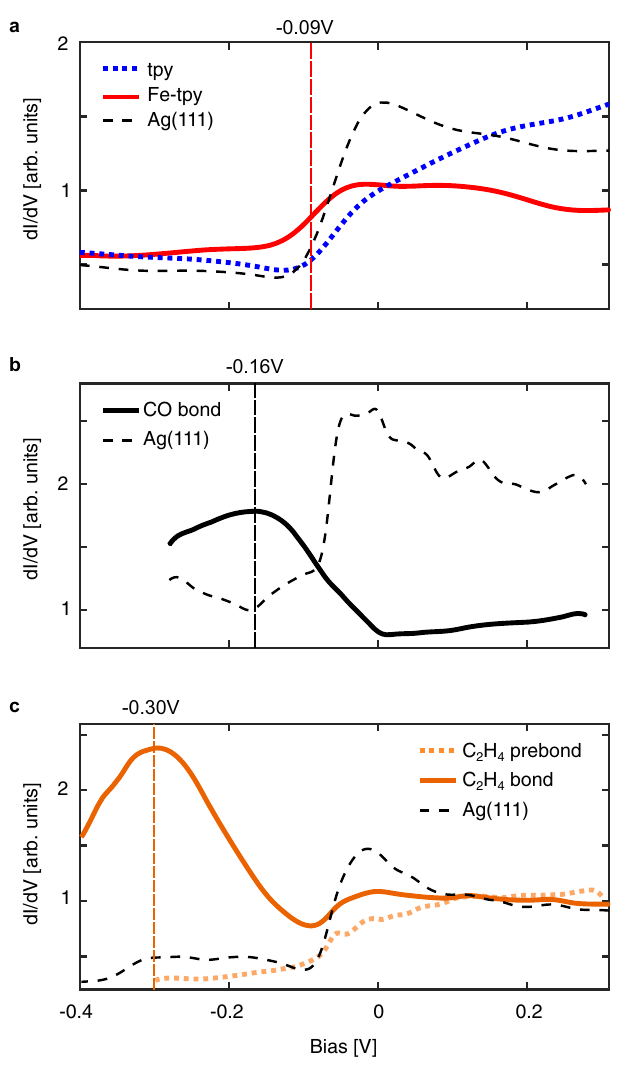
Fig. 5 | Tunnelling spectroscopy of Fe sites. Averaged d I /d V comparing the bare active site signal ( a , red solid line; position identi fi ed from comparing tpy-Fe rela- tive to ligand) with the CO bond ( b , black solid line), C 2 H 4 prebond ( c , orange dotted line), and C 2 H 4 bond ( c , orange solid line) tunnelling resonances. A clear shiftintheFe-centredstateat V = − 0.09V( a )isobserveduponCObondformation at V = − 0.16V( b )andC 2 H 4 bondformationat V = − 0.30V( c ).TheC 2 H 4 prebond( c ) does not exhibit deviation from the Fe-tpy resonance at V= − 0.09V. Spectra